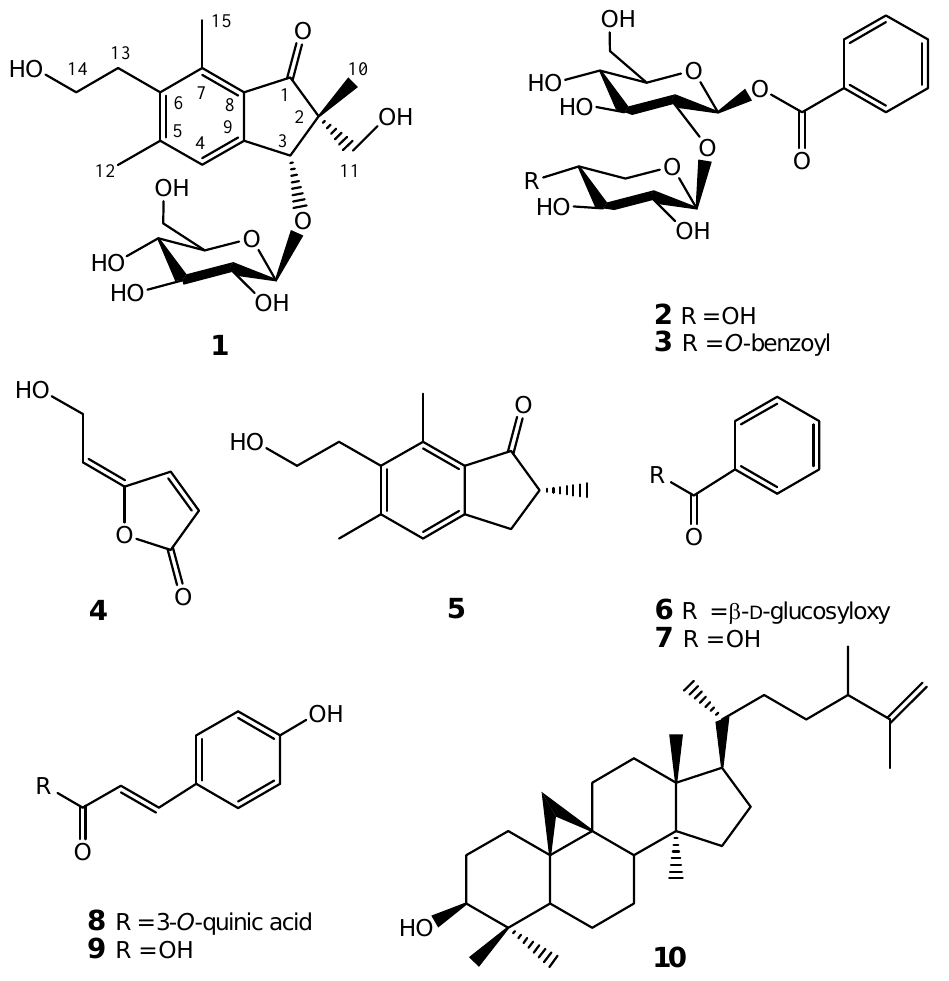
Figure 1. Structures of compounds 1 - 10